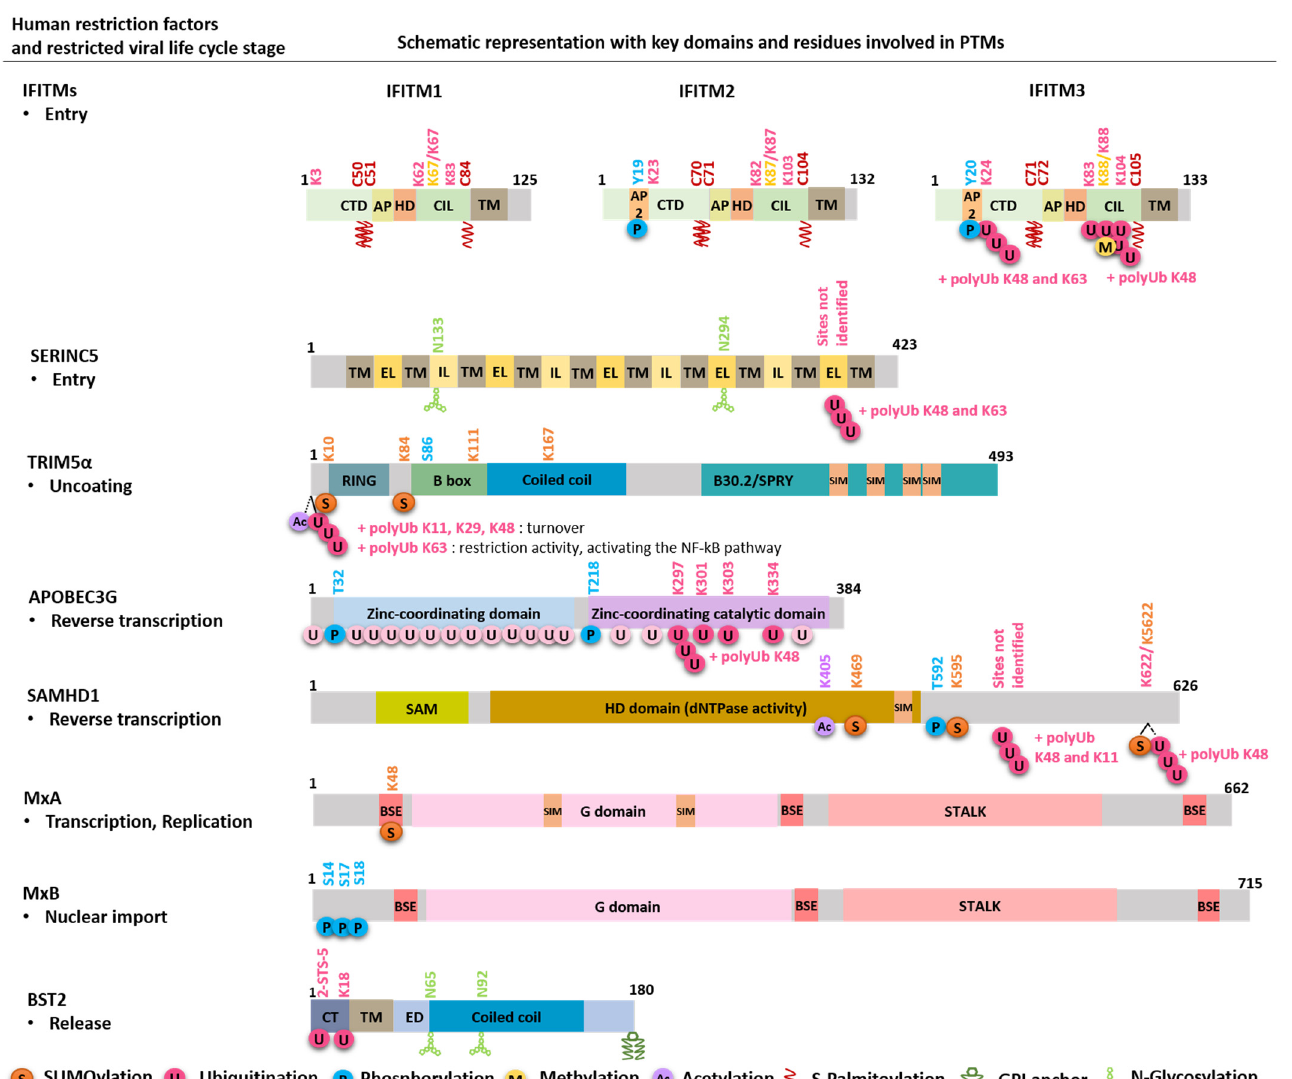
Figure 2. Schematic representation of human restriction factors, with key domains and residues involved in PTMs. For each restriction factor, the target viral step is indicated, and the modification residue and the corresponding PTM are marked with same colors. The 20 putative lysines (K) in APOBEC are K2, 40, 42, 52, 63, 76, 79, 99, 113, 141, 150, 163, 180, 249, 270, 297, 301, 303, 334 and 344. The four residues critical for Vif-induced APOBEC proteasomal degradation are indicated, although their importance remains controversial. CTD: cytoplasmic C-terminal domain; AP2: AP2 binding domain, AP: amphipathic helix; HD: hydrophobic domain; CIL: conserved intracellular loop; TM: transmembrane domain; IL: intracellular loop; EL: extracellular loop; SIM: SUMO-interacting motif; SAM: sterile alpha motif; HD domain: histidine-aspartic-containing domain; BSE: bundle-signaling element; G domain: GTPase domain; CT: cytoplasmic tail; ED: extracellular domain.